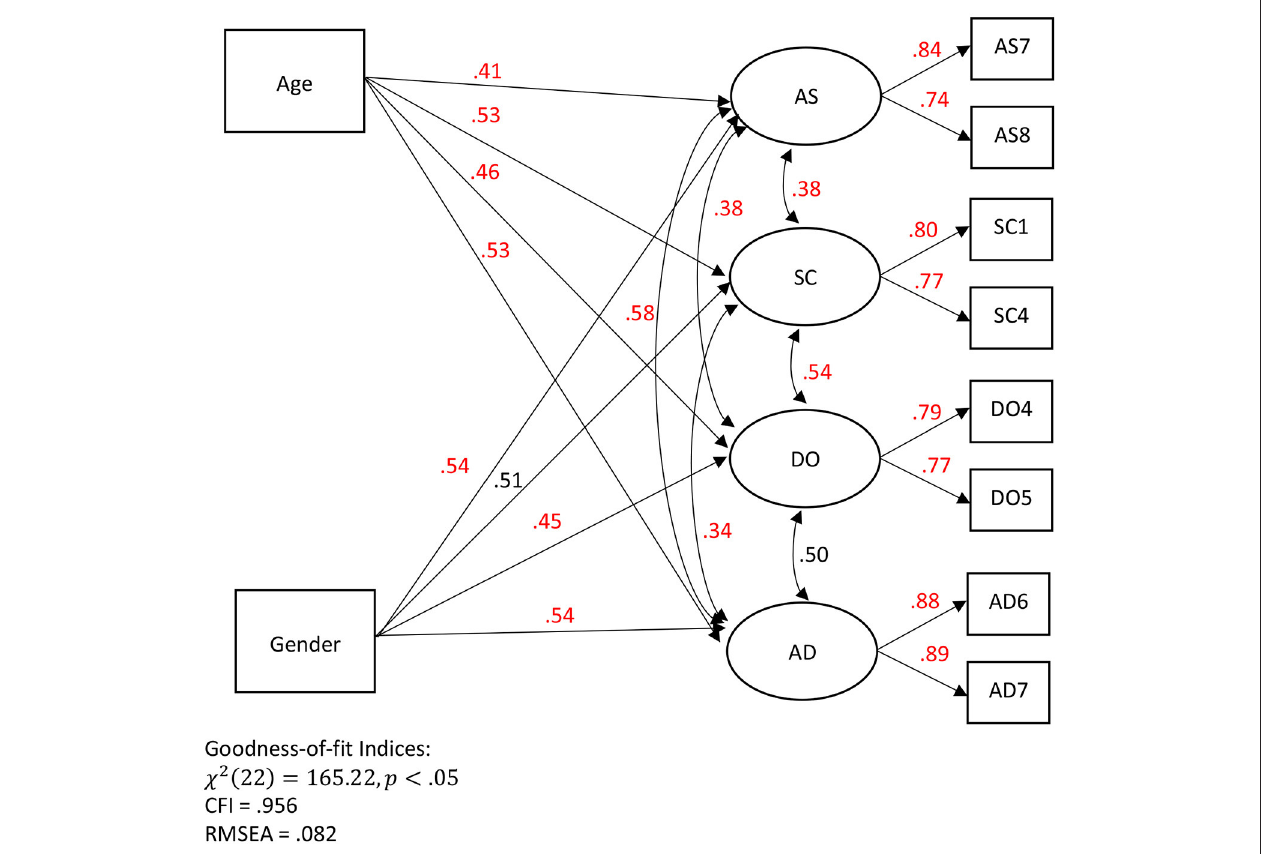
FIGURE 8 | An interpreted SEM with the PS-ML estimates. AS refers to assertiveness, SC refers to social confidence, DO refers to dominance, and AD refers to adventurousness. PS-based estimates with p < 0.01 are presented in red.